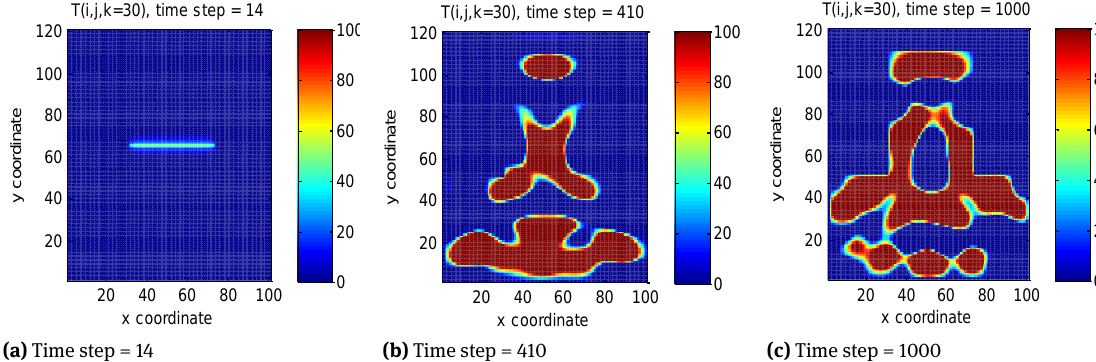
Figure 9: Temperature field distribution with no material in cavity at different time step